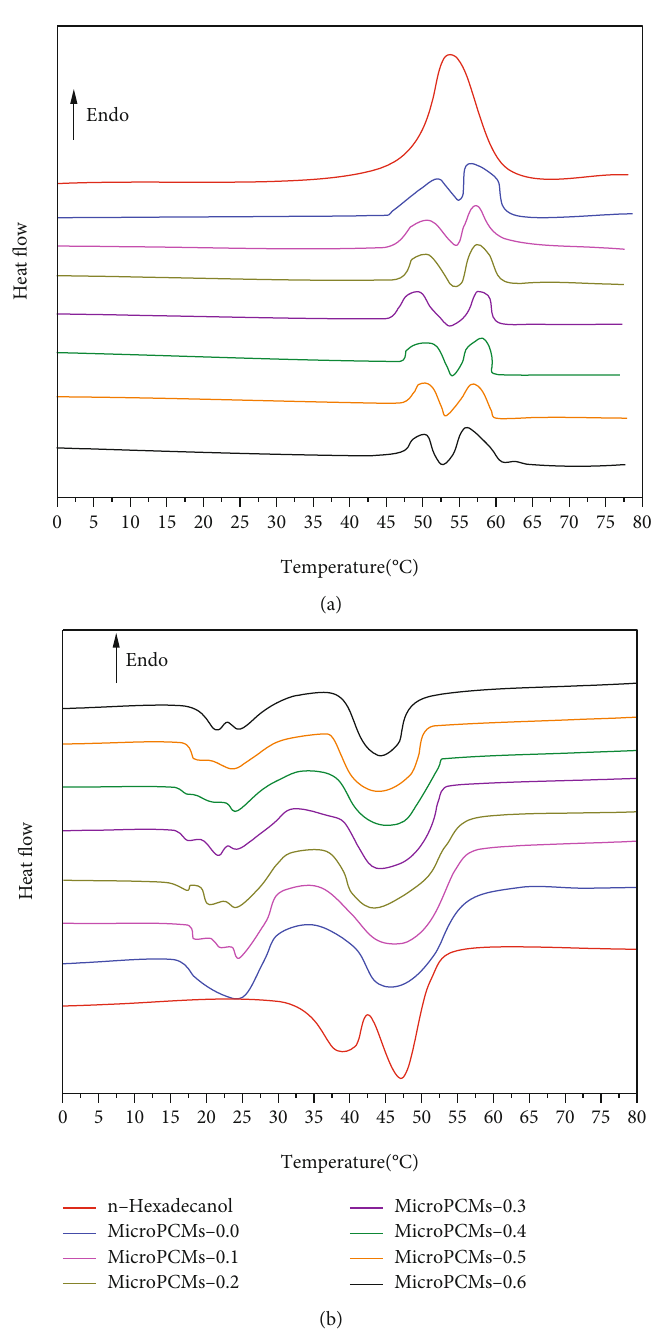
Figure 1: (a) The melting and (b) crystallizing processes in n-hexadecanol and microPCMs, respectively, as depicted by DSC